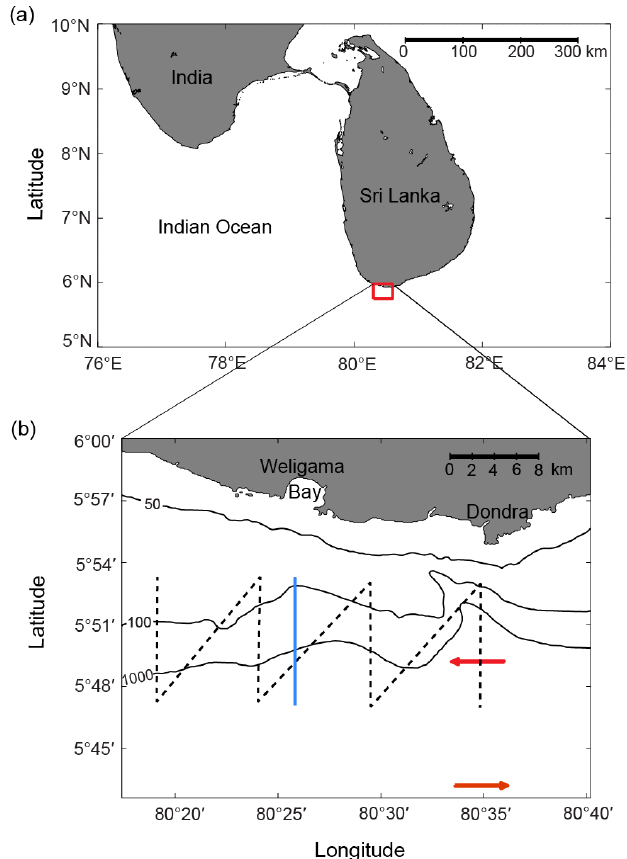
Figure 1. ( a ) Location map of study area on the southern coast of Sri Lanka delineated by the red box. ( b ) Dashed lines indicate saw tooth transect tracklines in 2011 and 2012. Blue-grey vertical line directly south of Weligama Bay represents the Conductivity-Temperature-Depth (CTD) transect used to gather salinity, temperature and density data. Red arrows indicate the major east-west shipping route across the Indian Ocean from Admiralty